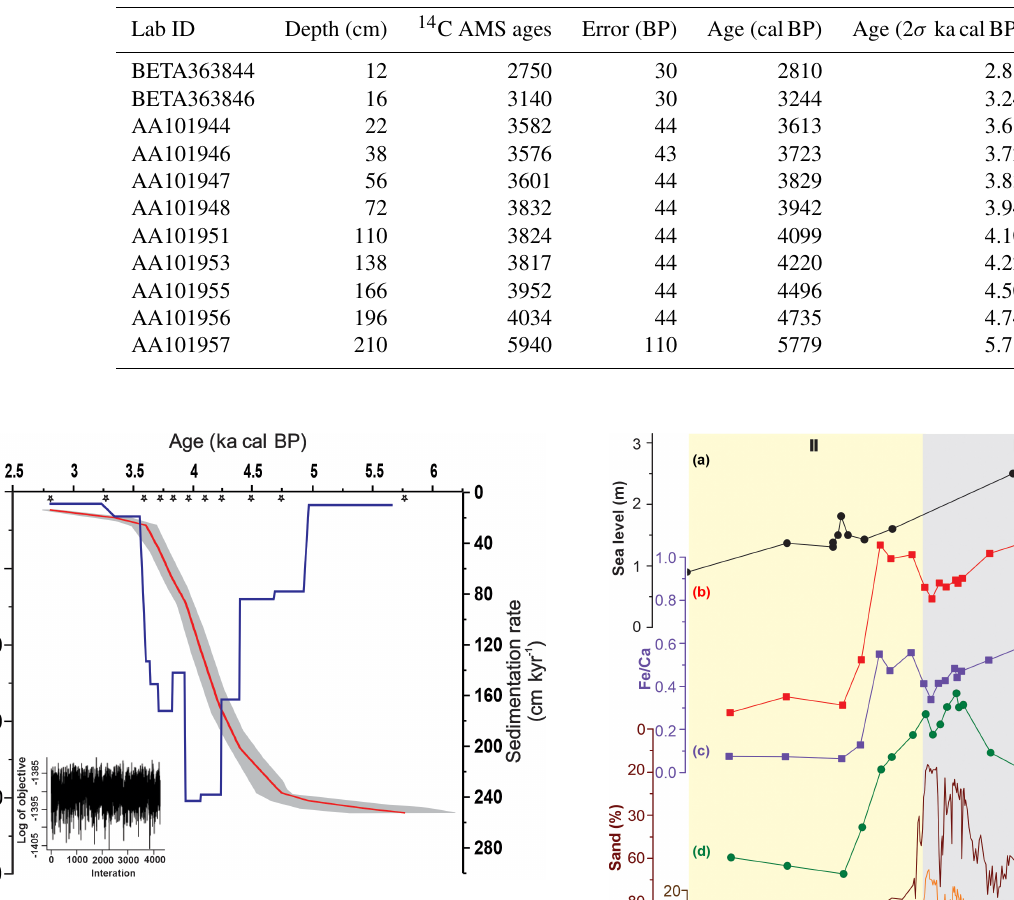
Figure 2. Bayesian age–depth model performed with BACON (Blaauw and Christeny, 2011) for the core S-15 (red line) and un- certainty (smooth gray curve) from Lagoa Salgada, Rio de Janeiro state, Brazil, with sedimentation rate (cmkyr − 1 ) (blue line). Black stars indicate the position of the 11 radiocarbon dates measured. The inset shows the iteration history.